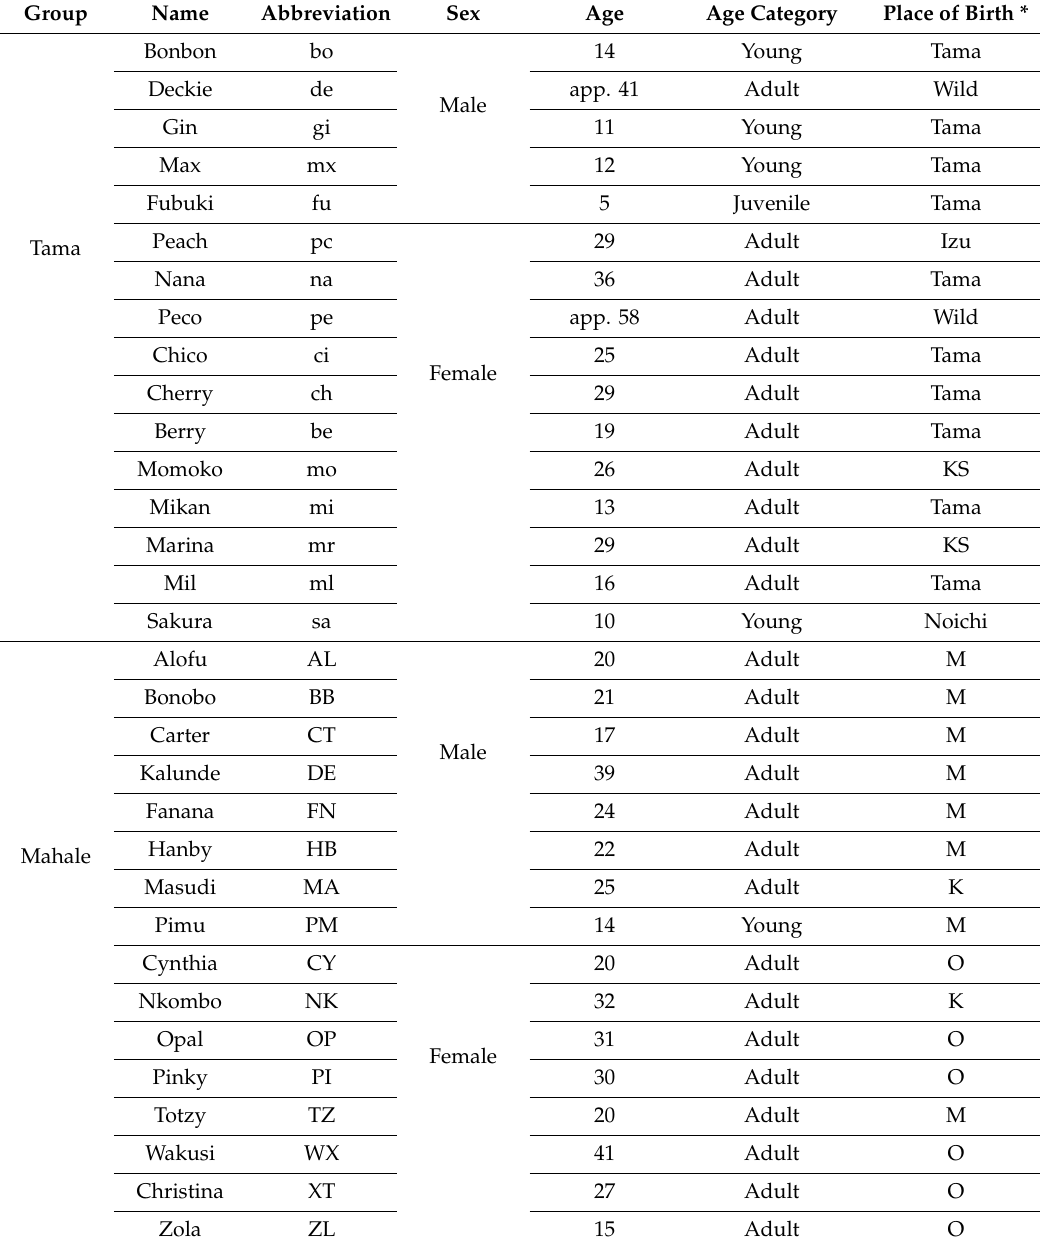
Table 1. The list of focal individuals in both study groups. * Tama, Tama Zoological Park, Tokyo; Wild, born in wild; Izu, Izu Shaboten Zoo, Shizuoka; KS, Kumamoto Sanctuary, Kumamoto; Noichi, Noichi Zoological Park, Kochi; M, M group in Mahale [36], K, K group in Mahale [36], O, a group other than M or K group